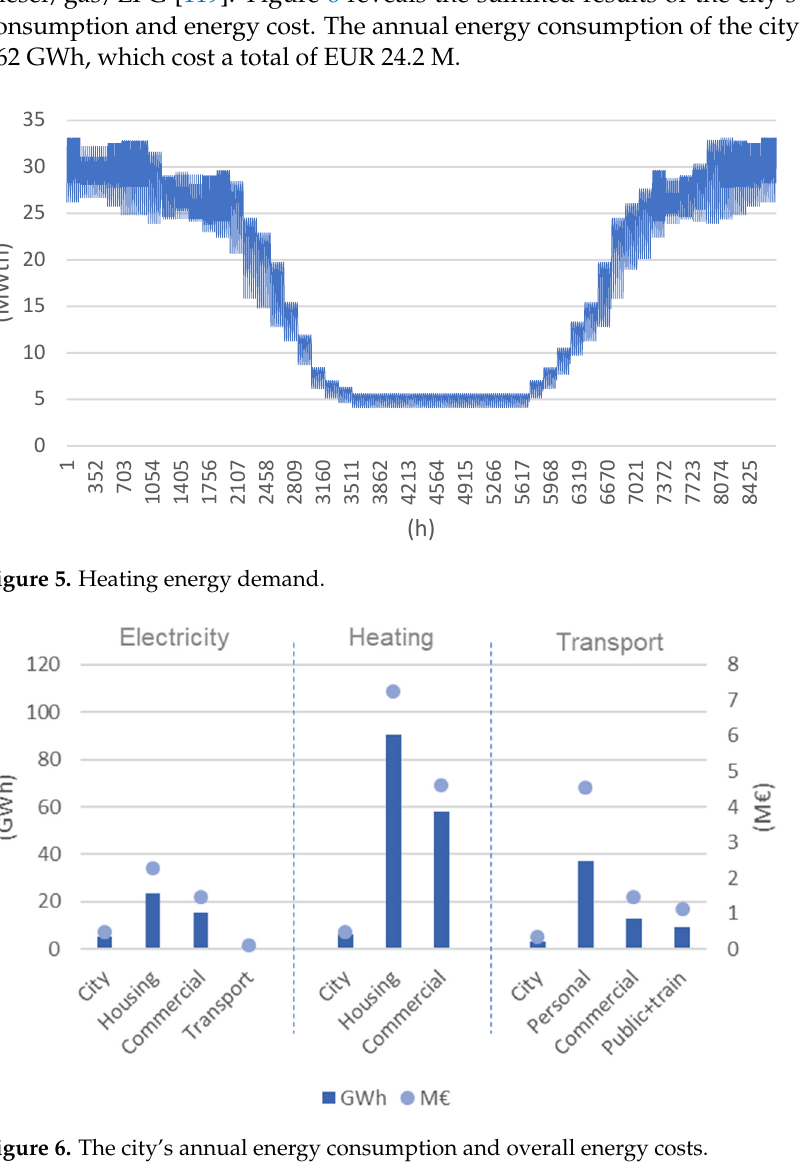
Figure 6. The city’s annual energy consumption and overall energy costs.